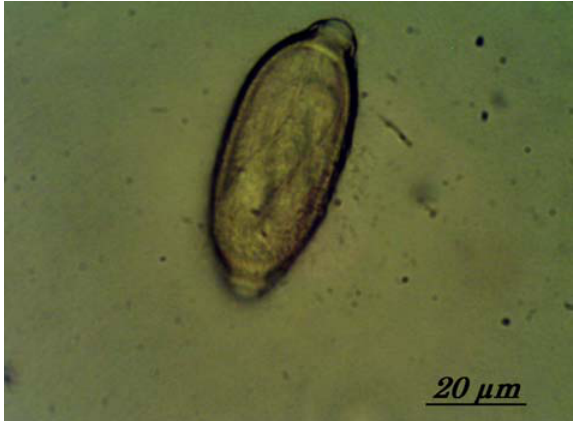
Fig. 2. Egg nematodes of the species Aonchotheca bovis of the control culture with the formed larvae at day 27 of the